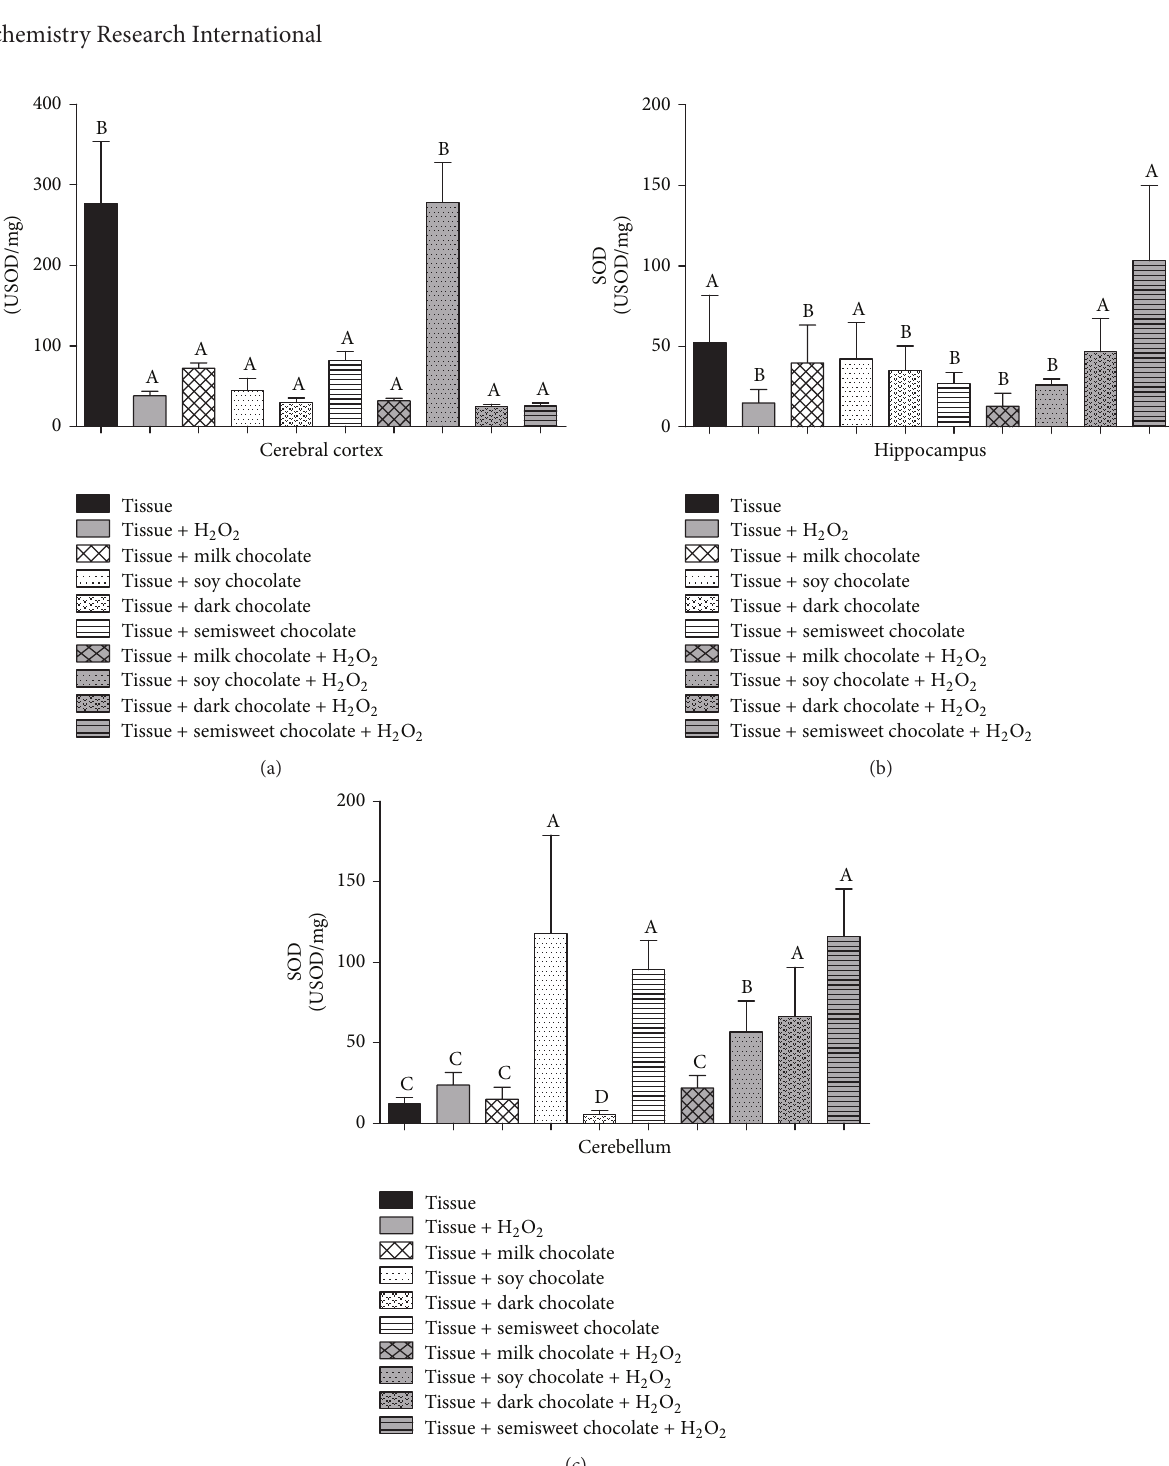
chocolate is the one that has greater amount of sugar in